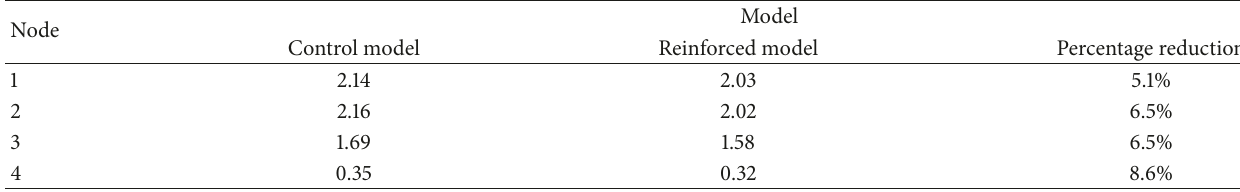
Table 2: Maximum displacement (mm) of the control and reinforced models.